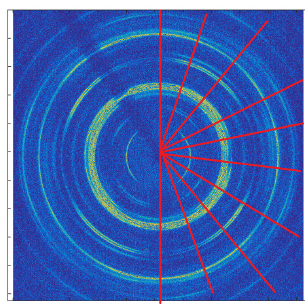
Figure 2. Indication of nine sectors in which the integration was carried out. Each sector has angular width of